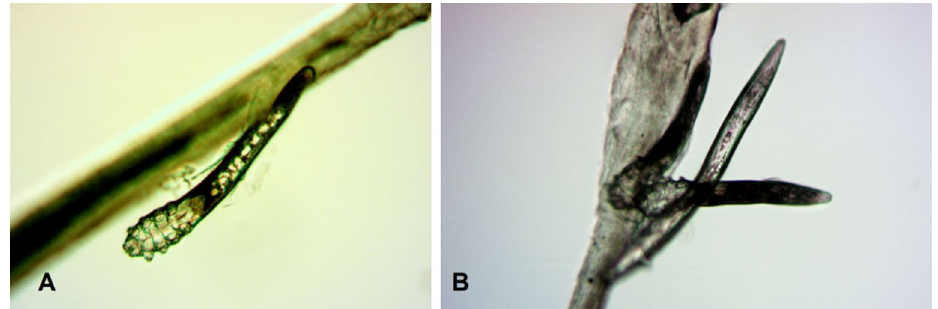
Figure 1. Adult stage of Demodex folliculorum (A) and two adults and one larva of D. folliculorum (B) . Photo: Witold Tarkowski.